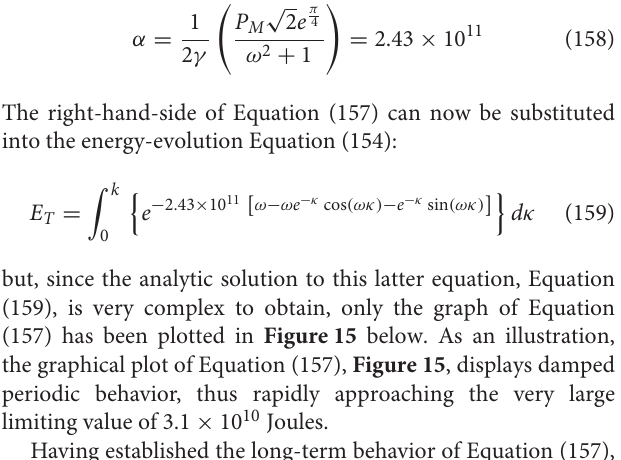
spatial limits, ultimately yields a value approaching a constant total energy magnitude with increasing time and space, seen in Figure 15 below. This is because the exponent in Equation (159) has a negative limiting value , meaning the exponential of this parameter results in a constant result for the long-term energy